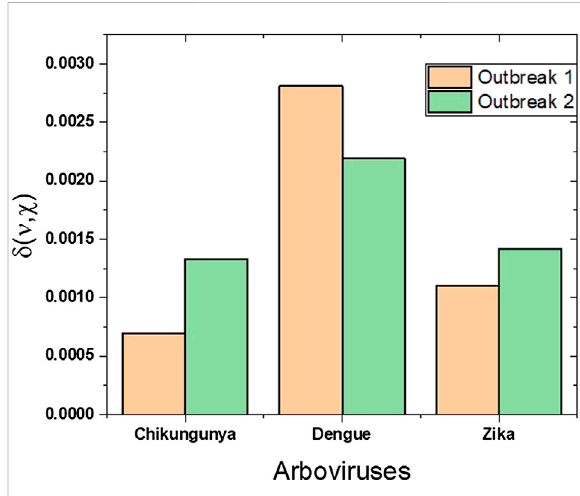
FIGURE 9 Dissimilaritybetweenthe networks ofnoti fi edand con fi rmed of Chikungunya, Zika and Dengue.